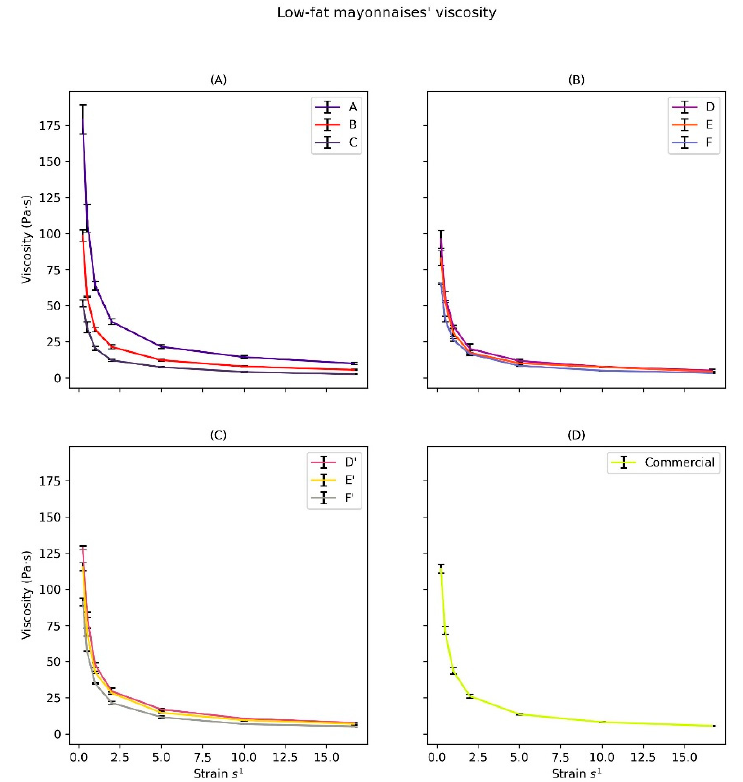
Figure 4. The viscosity of different low-fat mayonnaises at different strain stress. ( A ) Sodium alginate low-fat mayonnaises (A, B, C = 30, 22.5, 15% oil, respectively). ( B ) Low-fat mayonnaises with soy protein isolate (D, E, F = 30, 22.5, 15% oil, respectively). ( C ) Low-fat mayonnaises with spirulina protein concentrate (D’, E’, F’ = 30, 22.5, 15% oil, respectively). ( D ) Commercial low-fat mayonnaise.